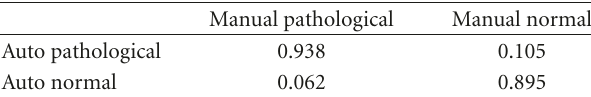
Table 8: Confusion matrix for the two correlations case (Test set).